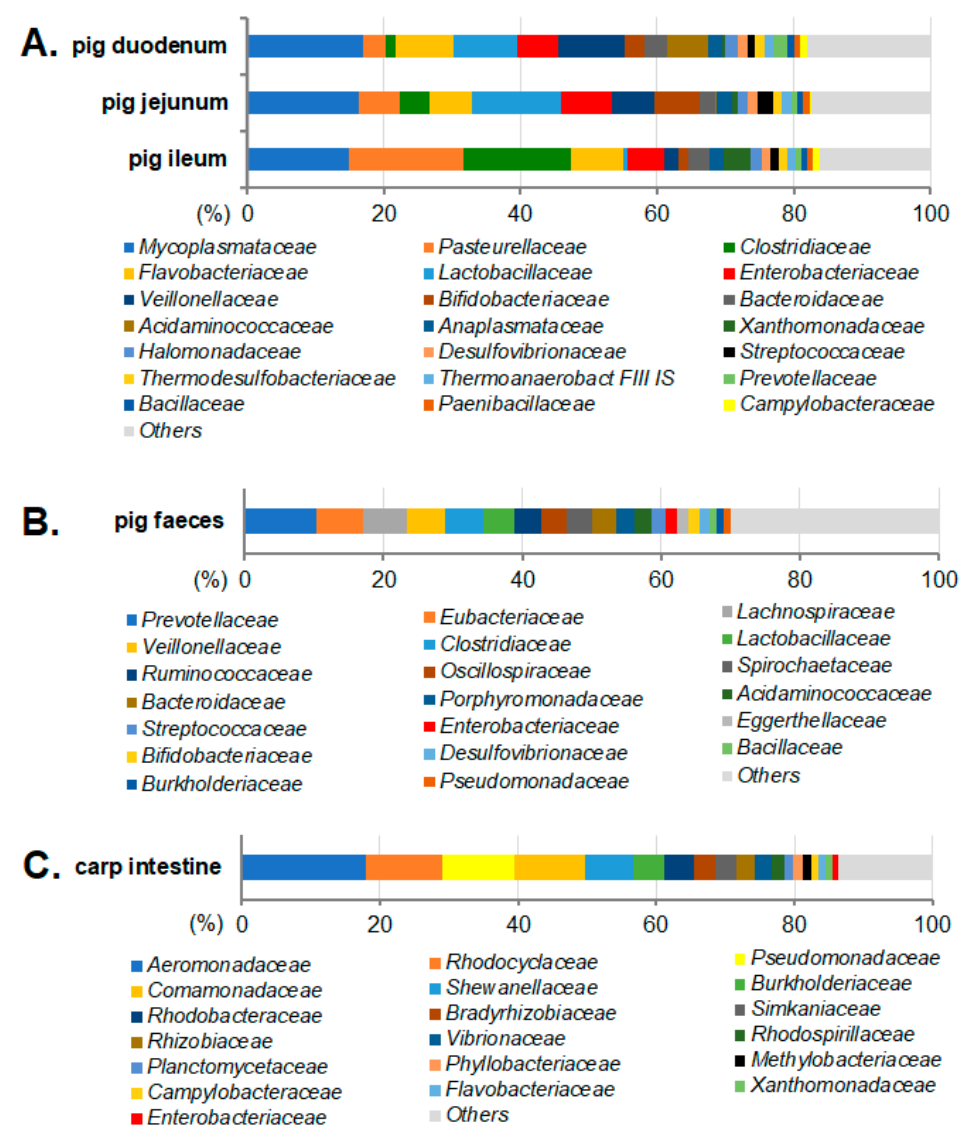
Figure 1. Mean proportions (%) of different bacterial families among metagenomic contigs classified to the kingdom of Bacteria. Bacterial families assigned to metagenomic contigs for the swine small intestine ( A ), for swine feces ( B ) and for the carp intestine ( C ).